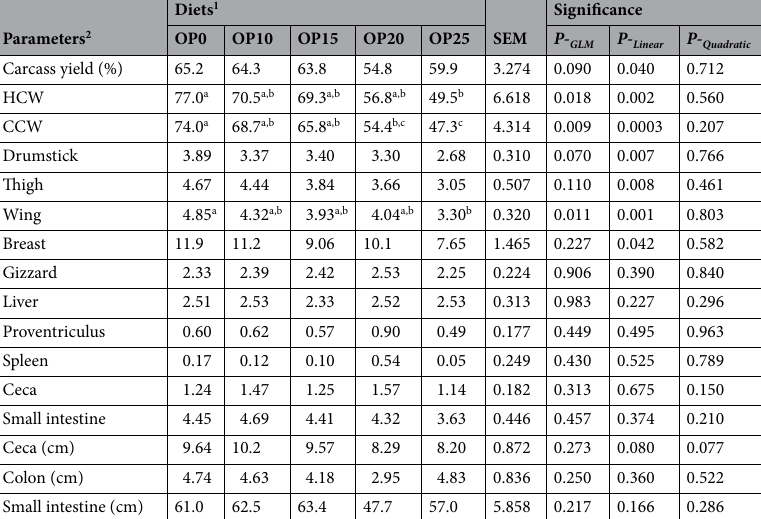
Meat quality. Table 6 shows that there were linear increases for 1-h breast meat yellowness ( b * (± 0.55) + 0.014 (± 0.104) x ; R 2 = 0.270, p = 0.009] and 1-h hue angle [ y = 0.39 (± 0.06) + 0.01 (± 0.01) x ; R 2 = 0.248, p = 0.010]. However, linear decreases were recorded for 24-h hue angle [ y = 0.56 (± 0.08)–0.01 (± 0.01) x ; R 2 = 0.318, p = 0.006] and 24-h redness ( a * 24 ) [ y = 6.81 (± 0.24)–0.11 (± 0.04) x ; R 2 = 0.256, p = 0.036] as dietary OP levels were increased. The dietary treatments had significant effects on a * 1 , b * 1 , chroma 1 , and hue angle 24 . Birds reared on diet OP25 had higher ( p < 0.05) a * 1 than those on diet OP10, but did not differ from those reared on OP0, OP15, and OP20. Quail reared on diet OP25 had higher b * 1 than those on diets OP15 and OP20, whose b * 1 were statistically similar ( p > 0.05) to those reared on diets OP0 and OP10. Diet OP10 promoted lower chroma 1